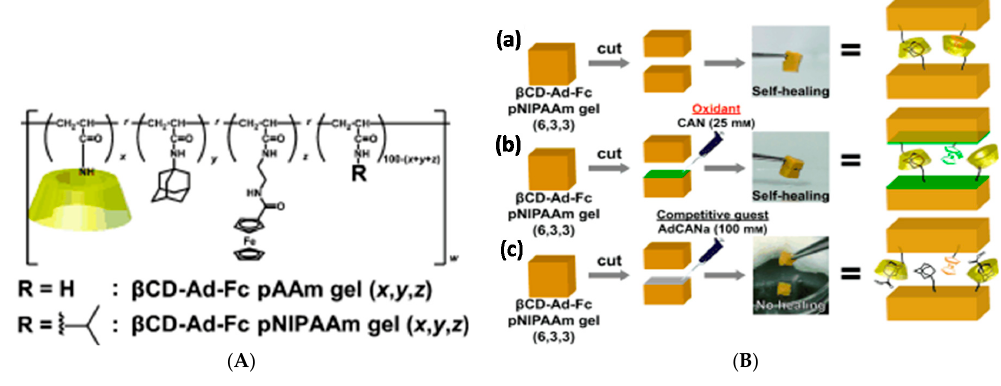
Figure 7. ( A ) Structures of copolymers bearing β -CD, adamantane (Ad) and ferrocene (Fc) in the same chain; x , y and z indicate mol% of respective units in the chain; ( B ) Self-healing properties of a poly( N -isopropylacrylamide) copolymer ( a ) with Fc in reduced form; ( b ) Fc in oxidized form; and ( c ) in the presence of competitive guest sodium adamantanecarboxylate (AdCANa). Reproduced with permission from [113]. Copyright 2016 John Wiley and